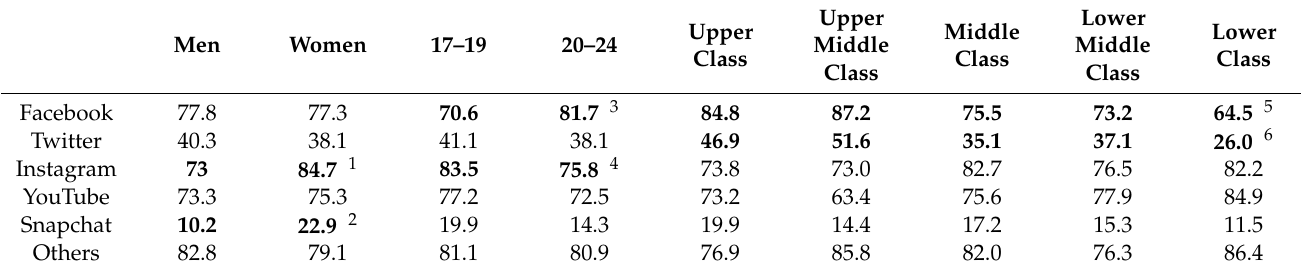
Table 1. Use of social networks by platform among young people from 17 to 24 years of age in the Autonomous Region of Madrid, according to gender, age group and social class (in